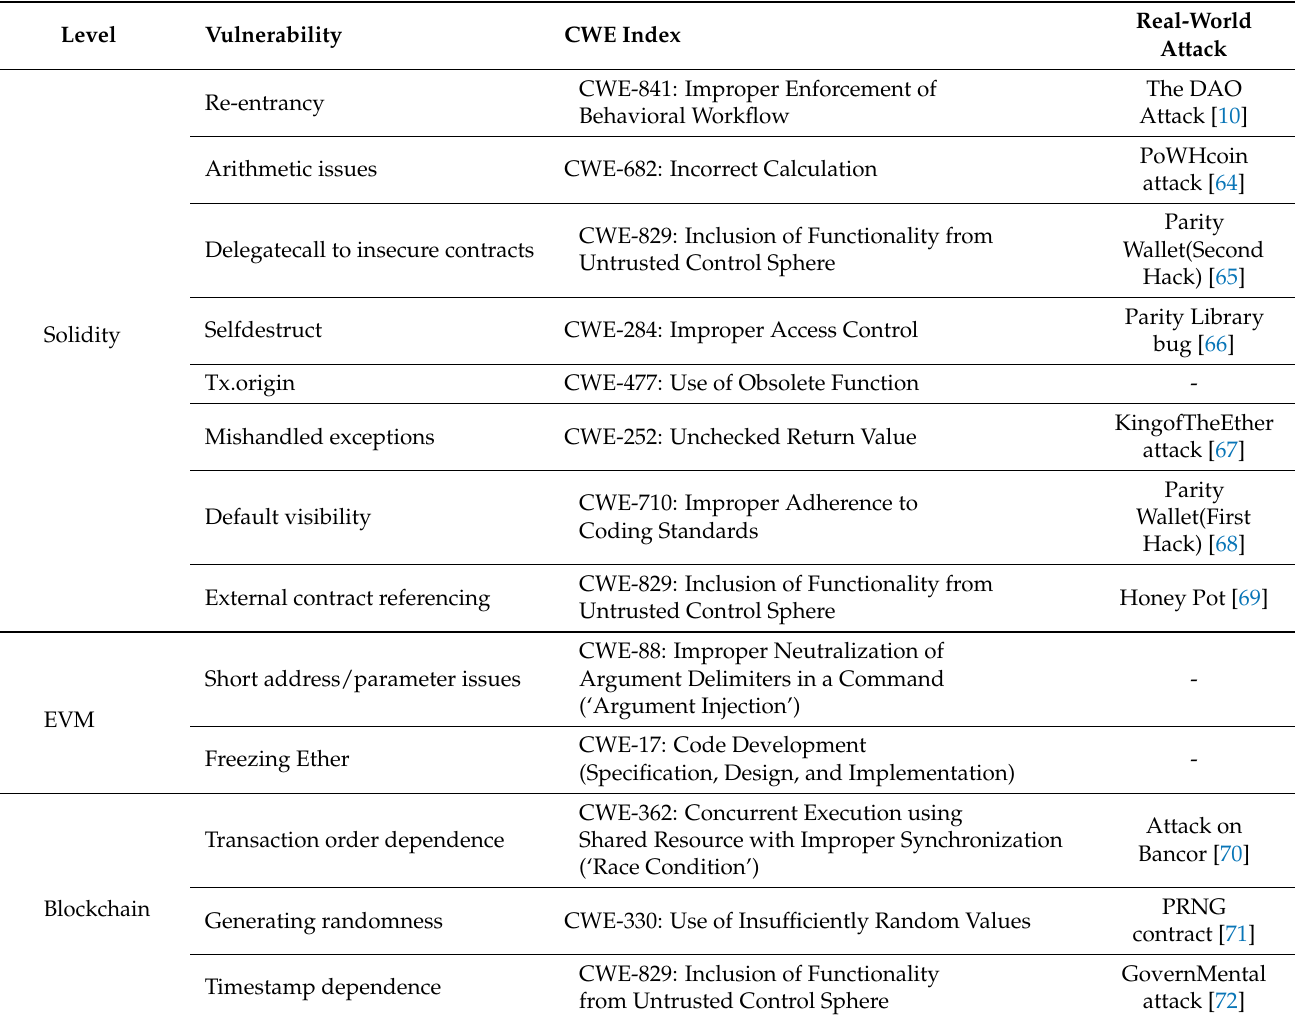
Table 2. Our taxonomy of smart-contract